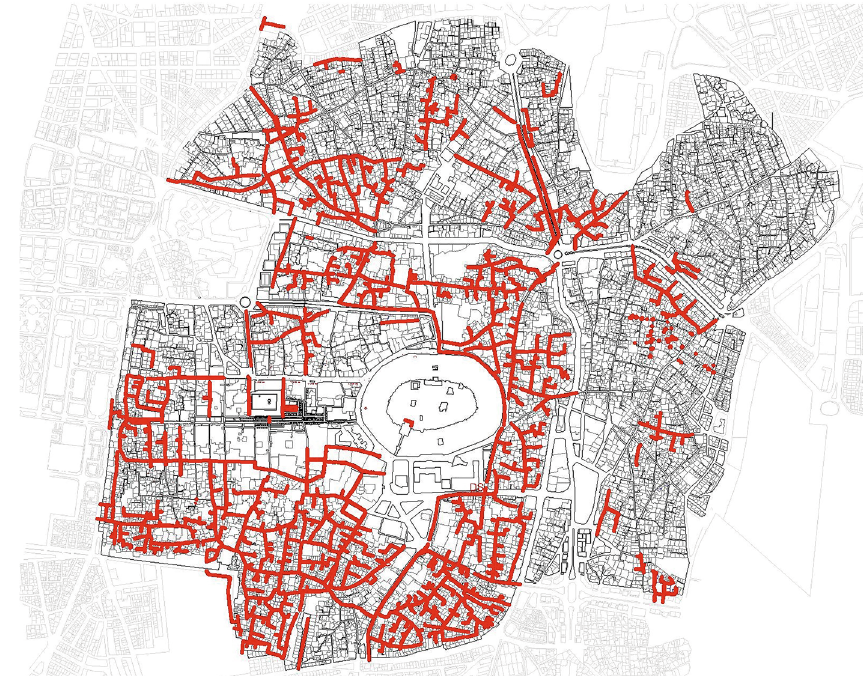
Fig. 12 Map Provided by Ammar Ghazal on the Renewal of Infrastructure Networks in 2005 (Source: GTZ and DOCA